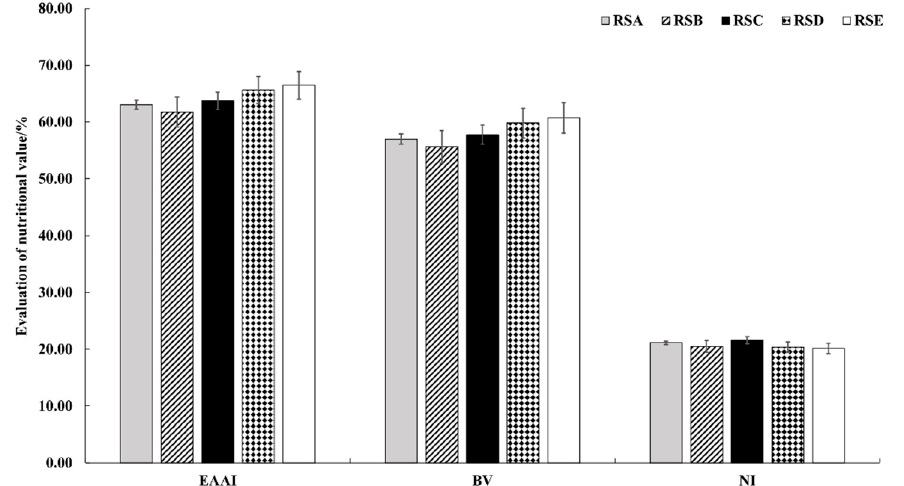
Figure 8. Effect of different rotation systems on essential amino acid indexes, biological values, and nutritional indexes of M. importuna . EAAI, essential amino acid indexes; BV, biological values; NI, nutrition indexes.